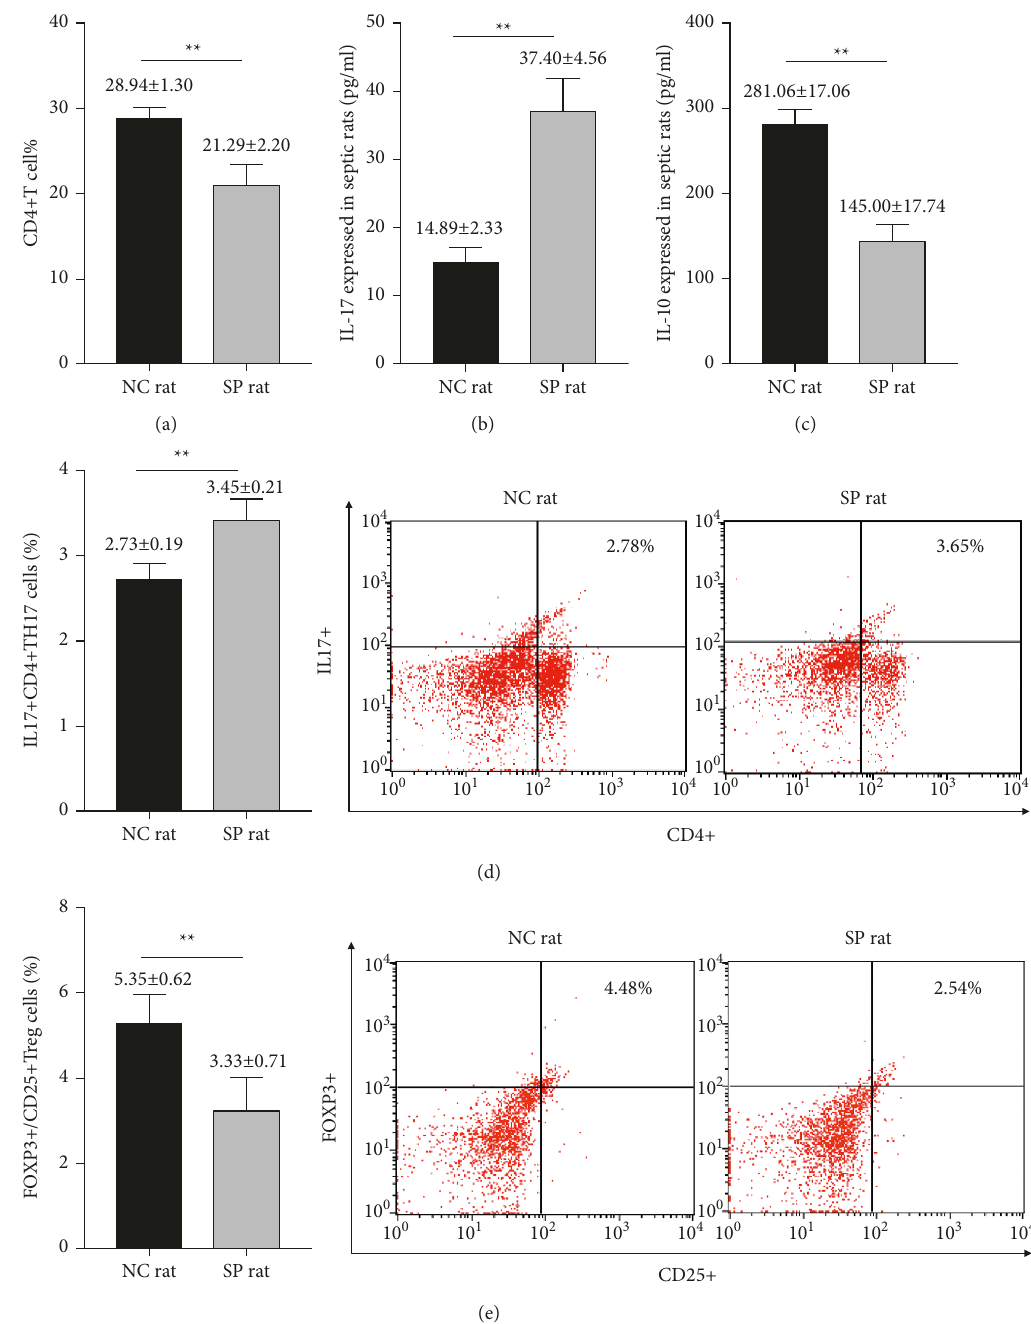
Figure 1: The proportions of lymphocytes and inflammatory factors were changed in peripheral blood of septic rats. (a) The ratios of CD4+ Tcells in peripheral blood in eight-paired NC rat group and SP rat group were determined by flow cytometry [ t value � 14.213, p < 0.01]. ((b) and (c)) The levels of IL-17 and IL-10 in peripheral blood in eight-paired NC rat group and SP rat group were determined by ELISA [ t value (IL-17) � 16.892, p < 0.01; t value (IL-10) � 16.312, p < 0.01]. (d) The ratio of Th17 cells in peripheral blood in eight-paired NC rat group and SP rat group were determined by flow cytometry [ t value � 5.687, p < 0.01]. (e) The ratios of Treg cells in peripheral blood in eight-paired NC rat group and SP rat group were determined by flow cytometry [ t value � 5.482, p < 0.01]. NC group: normal control group; SP group: sepsis group. ∗∗ p <